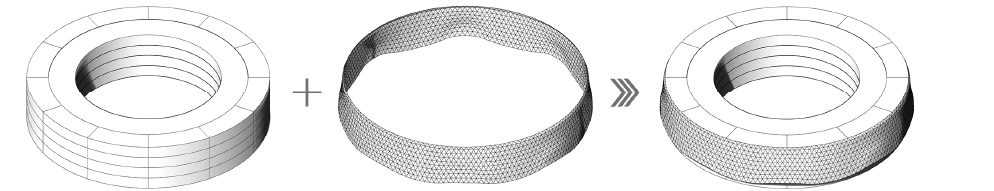
Figure 6. Parametric epidermal morphology generation results (self-developed).